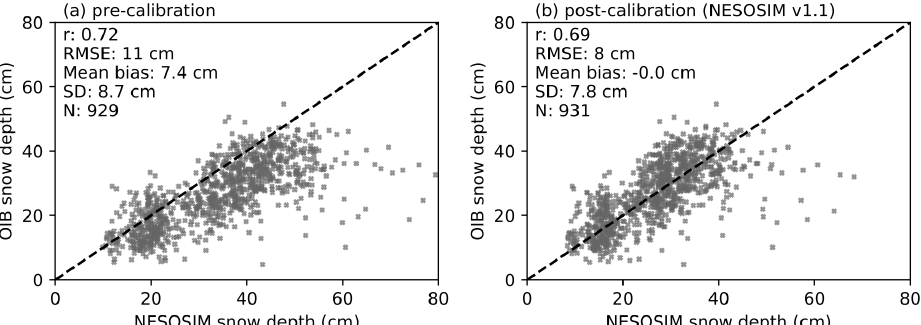
Figure 3. Comparison of (a) pre-calibration NESOSIM v1.1 and (b) post-calibration, NESOSIM v1.1 snow depths against spring (2010– 2015) Arctic snow depths from gridded daily spring 2010 to 2015 median Operation IceBridge (OIB) snow depth estimates.